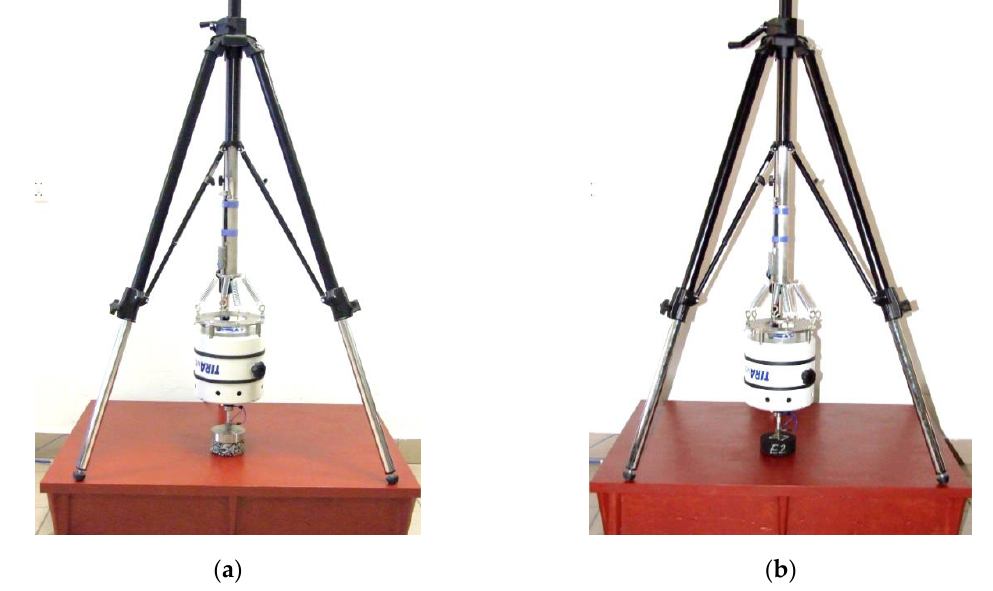
Figure 1. Test stand for measuring dynamic stiffness in laboratory and field conditions: ( a ) with massive load plate on the entire upper surface of the specimen; ( b ) with 30 mm diameter load plate.